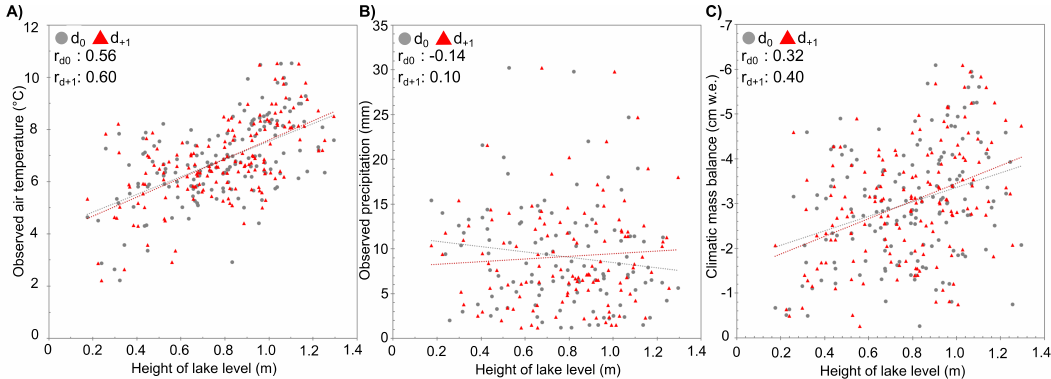
Figure 8. Correlations between ( A ) daily observed air temperature and change of lake level, ( B ) daily observed total precipitation and change of lake level, and ( C ) climatic mass balance averaged over the ablation area and changes of lake level height for the period October 2015 and April 2016. A time lag of +1 day (d + 1) is also